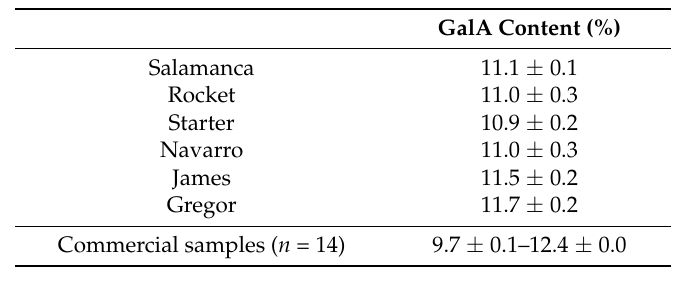
Table 3. GalA content of pea hulls (mean ± standard deviation (SD)); varieties in single-origin form and commercially available pea hull